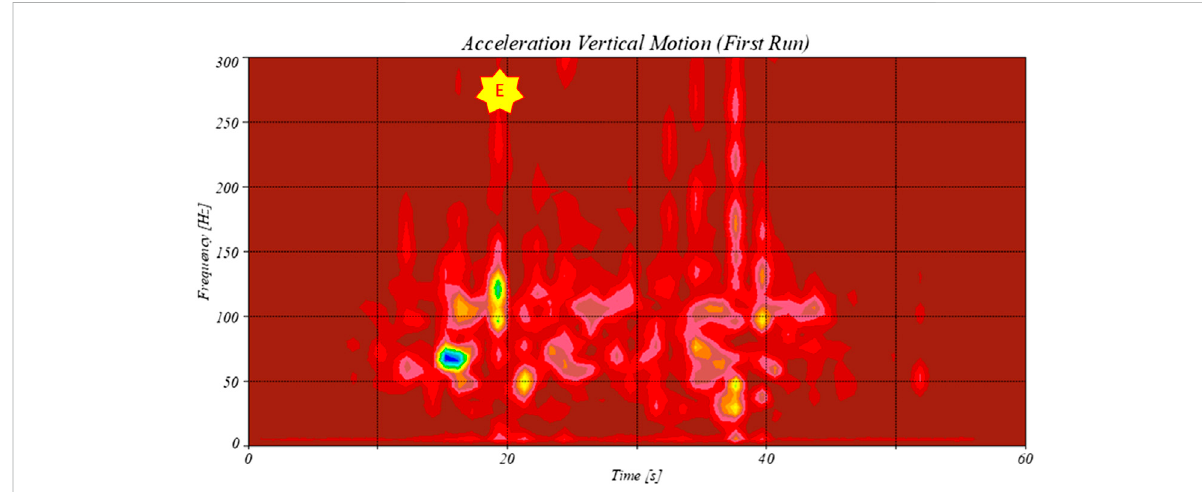
FIGURE 11 Spectrogram of the acceleration in the vertical direction (z). First run.